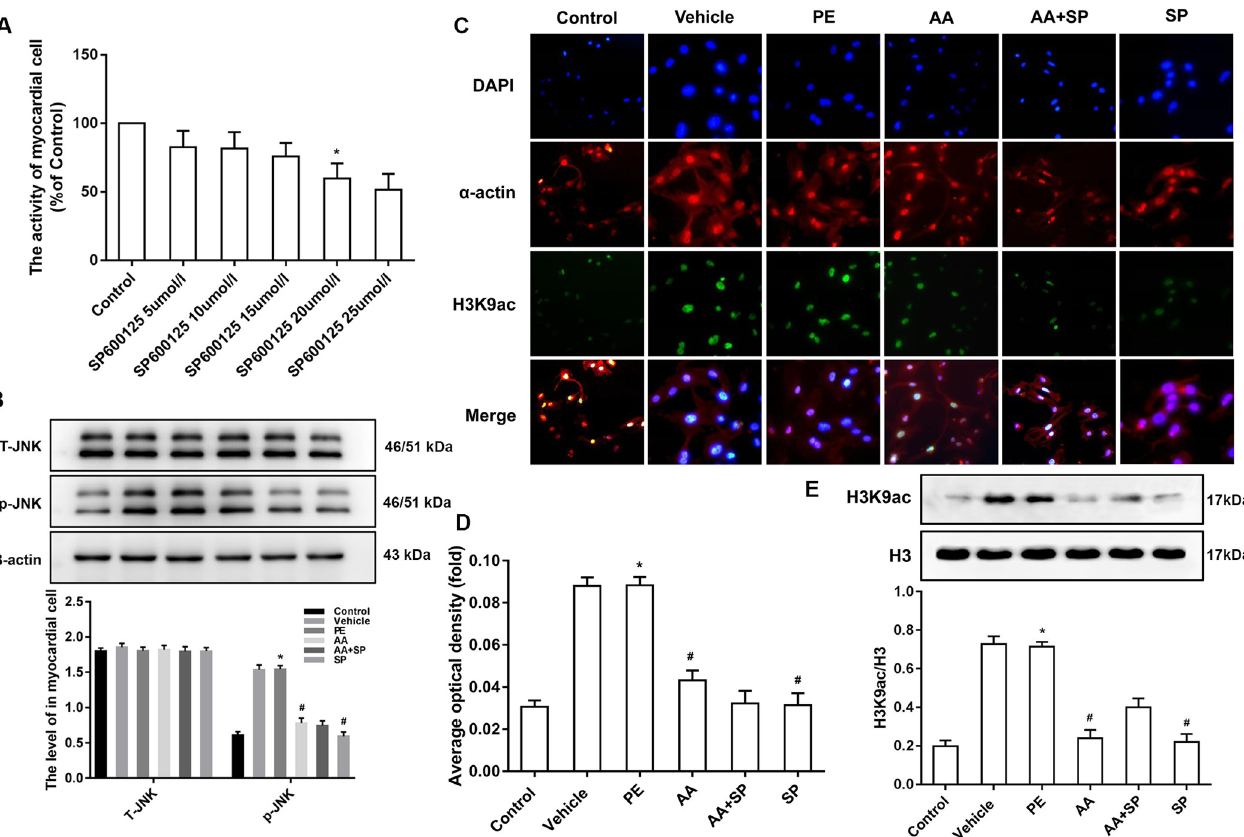
Fig 2. Effects of JNK/MAPK signaling and H3K9ac on mouse hypertrophic cardiomyocytes. (A) Effect of different concentrations of the JNK inhibitor SP600125 (0, 5, 10, 15, 20, and 25 μ mol/L) on cell viability of neonatal mouse cardiomyocytes by CCK-8 assays, and optimal dose (20 μ mol/L) of SP600125 was defined by taking into account myocardial cell viability. (B) Western blotting showing that p-JNK was significantly increased in myocardial cells exposed to phenylephrine (PE); the JNK inhibitor SP600125 decreased p-JNK overexpression in PE-induced hypertrophic cardiomyocytes but had not effect on T-JNK. (C) H3K9ac (green fluorescence) and α -actin (red fluorescence) combined with DAPI (blue fluorescence) staining in myocardial cells exposed to six different conditions. Scale bars, 20 μ m. (D) The statistical analysis of average optical density of H3K9ac immunofluorescence in the six groups. All results are representative of at least three independent experiments. (E) The level of H3K9ac was significantly increased in PE-induced hypertrophic cardiomyocytes; the HATs inhibitor anacardic acid (AA) attenuated histone H3K9ac hyperacetylation in PE-induced hypertrophic cardiomyocytes. � P < 0.05 vs . the control group, # P < 0.05 vs . the PE group (n = 3). DMSO: dimethylsulfoxide; SP: SP600125 (JNK inhibitor). Fluorescence quantification was done using ImageJ 1.8.0_112 software (https://imagej.nih.gov/ij/, 1997–2018). Figure created in IBM SPSS version 25 (https://www.ibm.com/analytics/spss-statistics-software). The